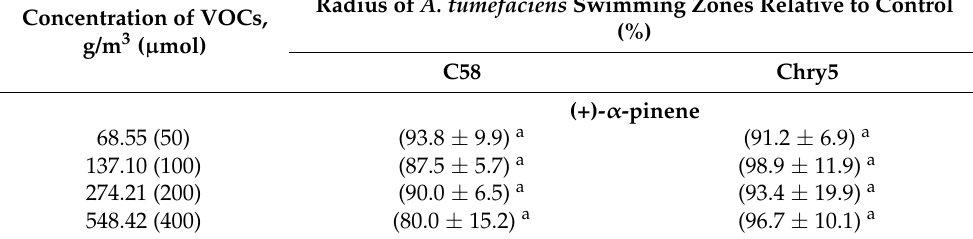
Table 2. Effect of VOCs on A. thaliana swimming motility *.